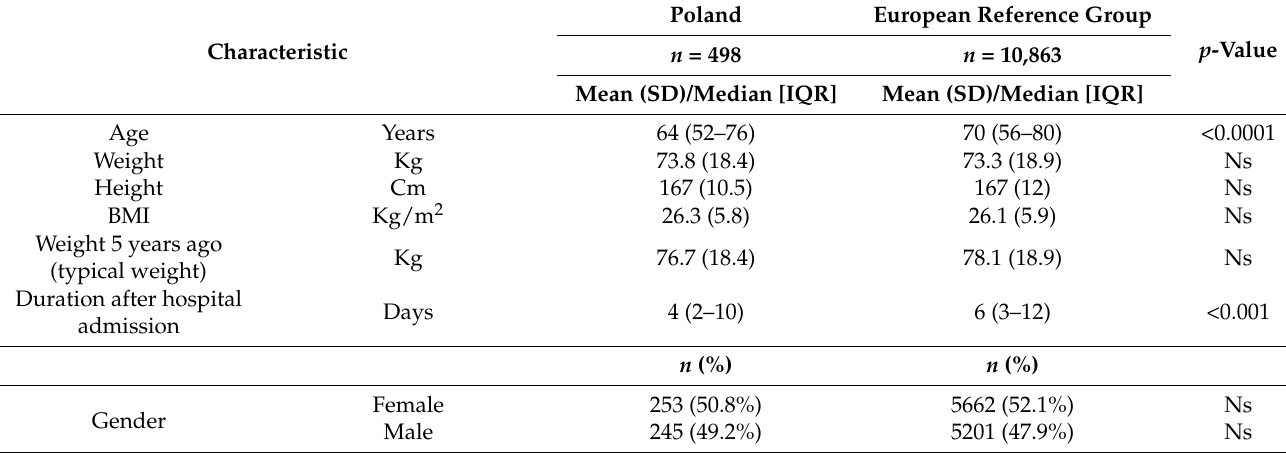
Table 2. Subjects’ characteristics including demographics of the study